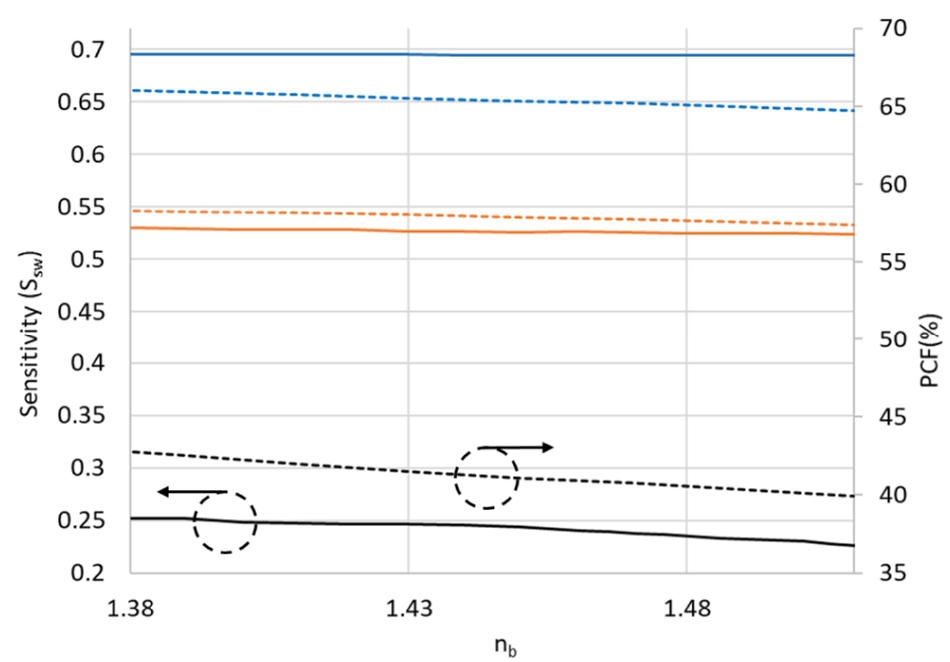
Figure 11. The variation of S sw when n b change from 1.34 to 1.51. The solid lines correspond to sensitivity and the dotted lines correspond to the power confinement factor. One, two and three slots are represented by black, orange and blue colors, respectively.